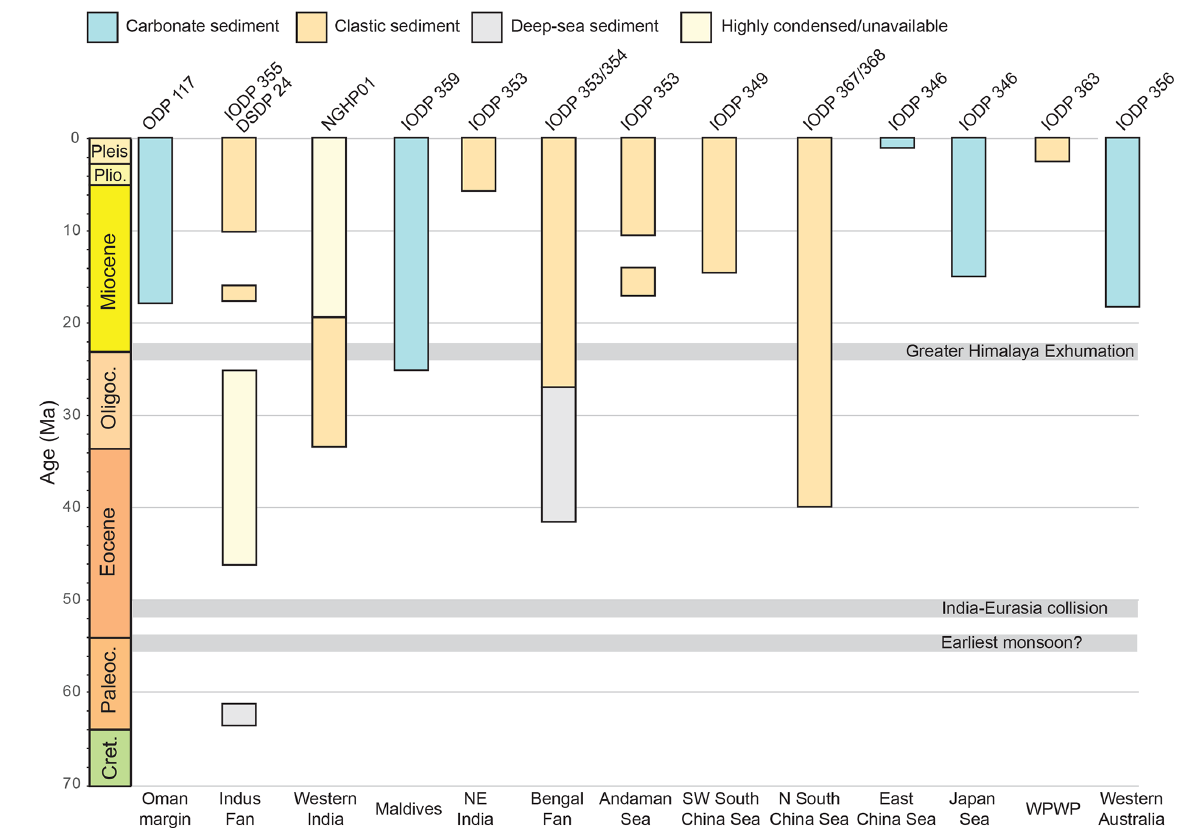
Figure 11. Summary of the temporal coverage now available across the marginal seas of monsoonal Asia, distinguishing between carbonate, biogenic, and oceanic sites and those comprising clastic sediments with records of continental erosion and weathering. Earliest monsoon age is from Licht et al. (2014). India–Eurasia collision age is from Najman et al. (2010). Greater Himalayan exhumation is from Godin et al.